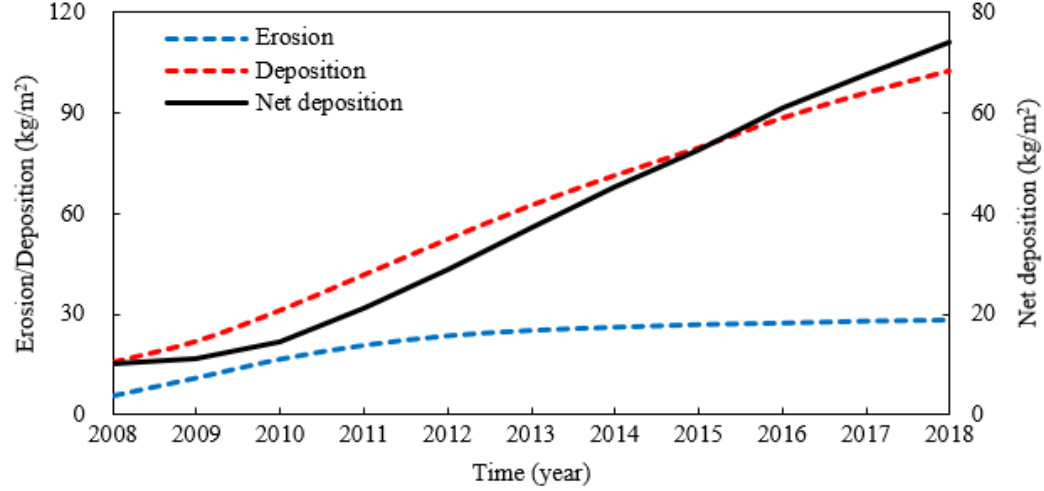
Figure 19. Amounts of erosion (blue dashed line), deposition (red dashed line) and net deposition (solid black line) per unit area for the QL system from 2008 to 2018.